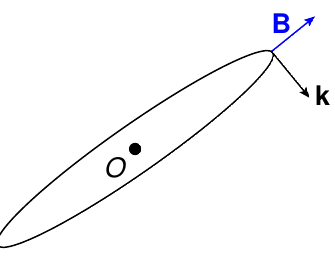
Figure 2 . A closed spatial loop tilted with respect to the equatorial plane, where O denotes the origin. A monopole magnetic field B generates a boost in the direction k